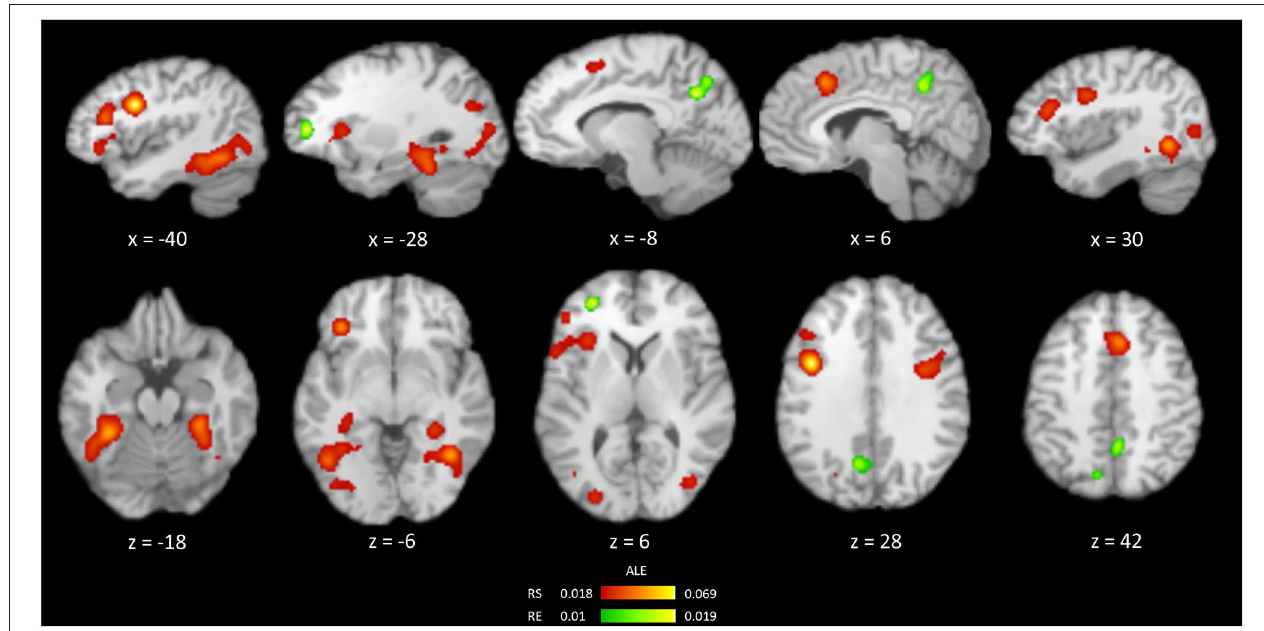
FIGURE 2 | Brain regions showing the occurrences of RS (red) and RE (green) from an ALE meta-analysis of all priming